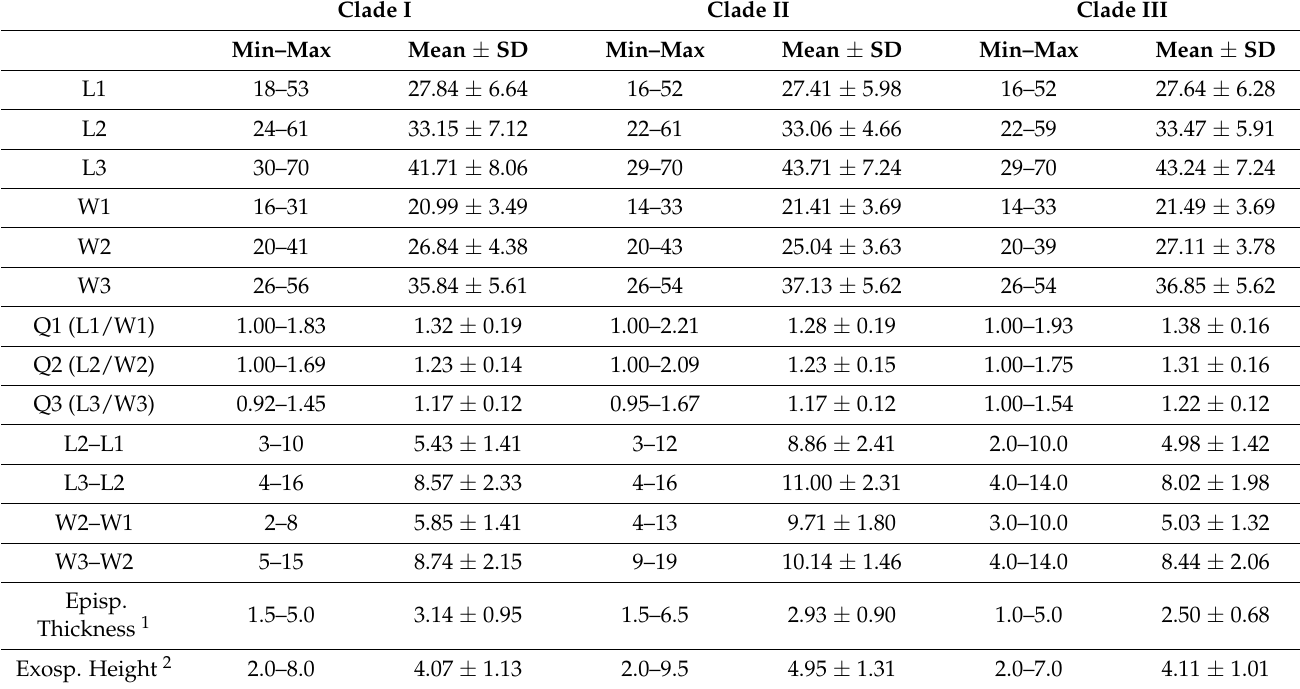
Table 3. Sporal dimensions of ascomata belonging to the three clades inferred in this study. Clade I Clade